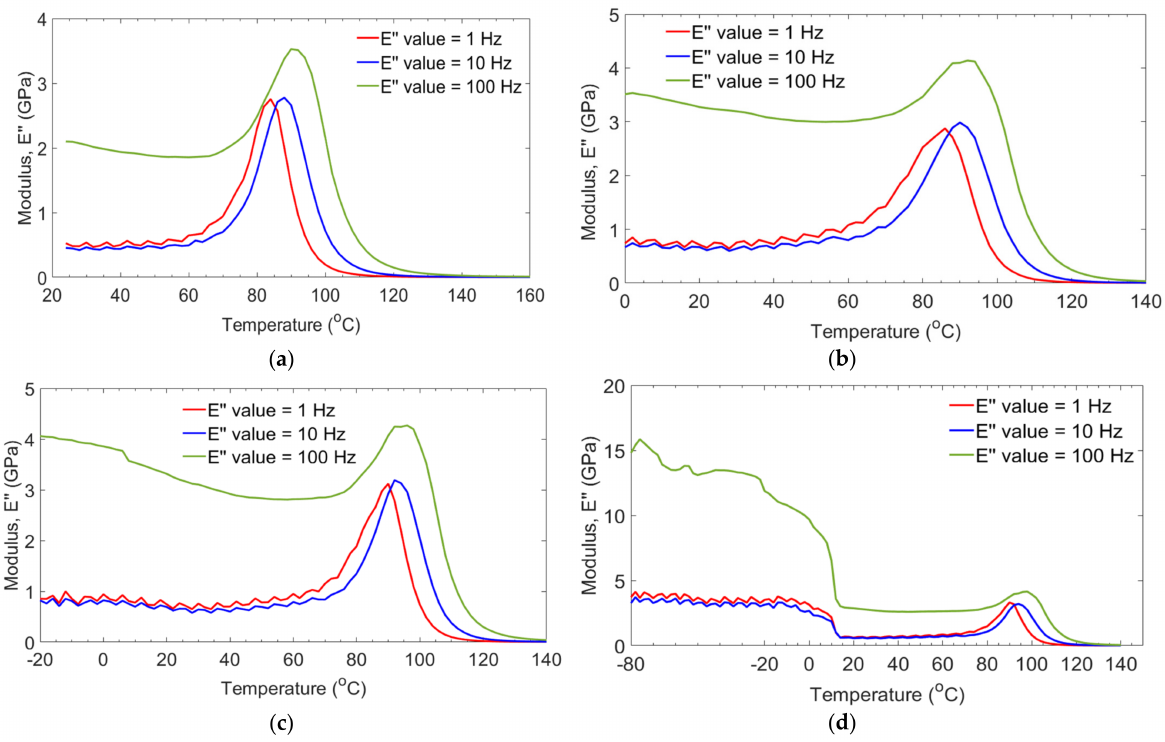
Figure 7. Loss modulus with temperature of GE control ( a ), 0/G ( b ), − 20/G ( c ), − 80/G ( d ) laminates.